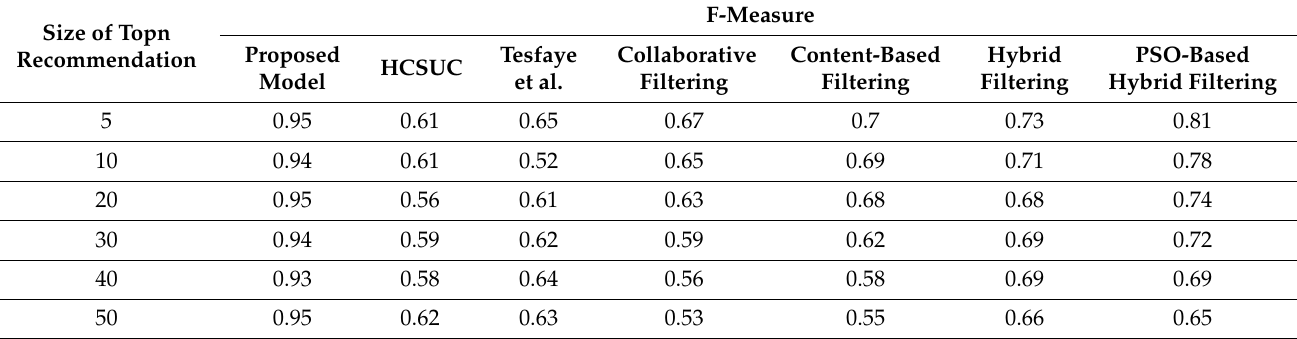
results demonstrate that the proposed model provides better recommendations compared to other models. Table 10. F-Measure according to the Topn Recommendation (Considering Dataset 2